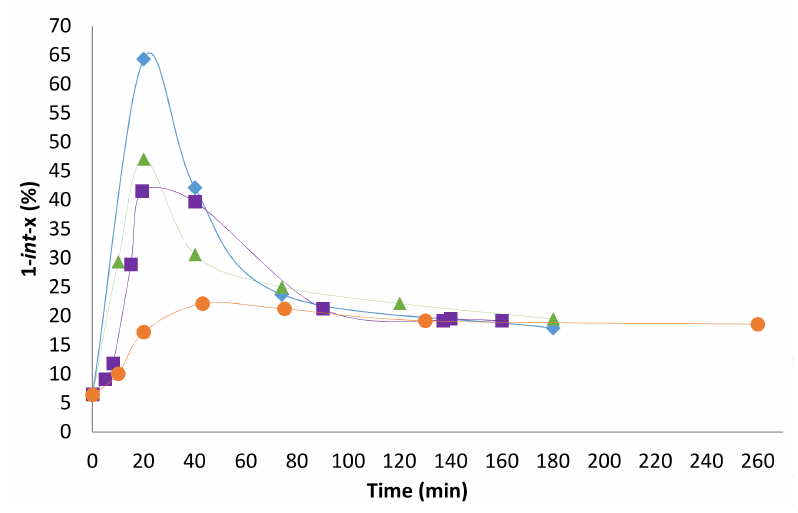
Figure 7. Influence of the [biphephos]/[Rh] ratio ([L]/[M]) on internal isomers ( 1- int -x ) as a function of time in tandem isomerization-hydroformylation of 10-undecenitrile at [ 1 ] 0 /[Rh] = 3000 ( (cid:7) [L]/[M] = 5, (cid:78) [L]/[M] = 10, (cid:4) [L]/[M] = 20, [L]/[M] =